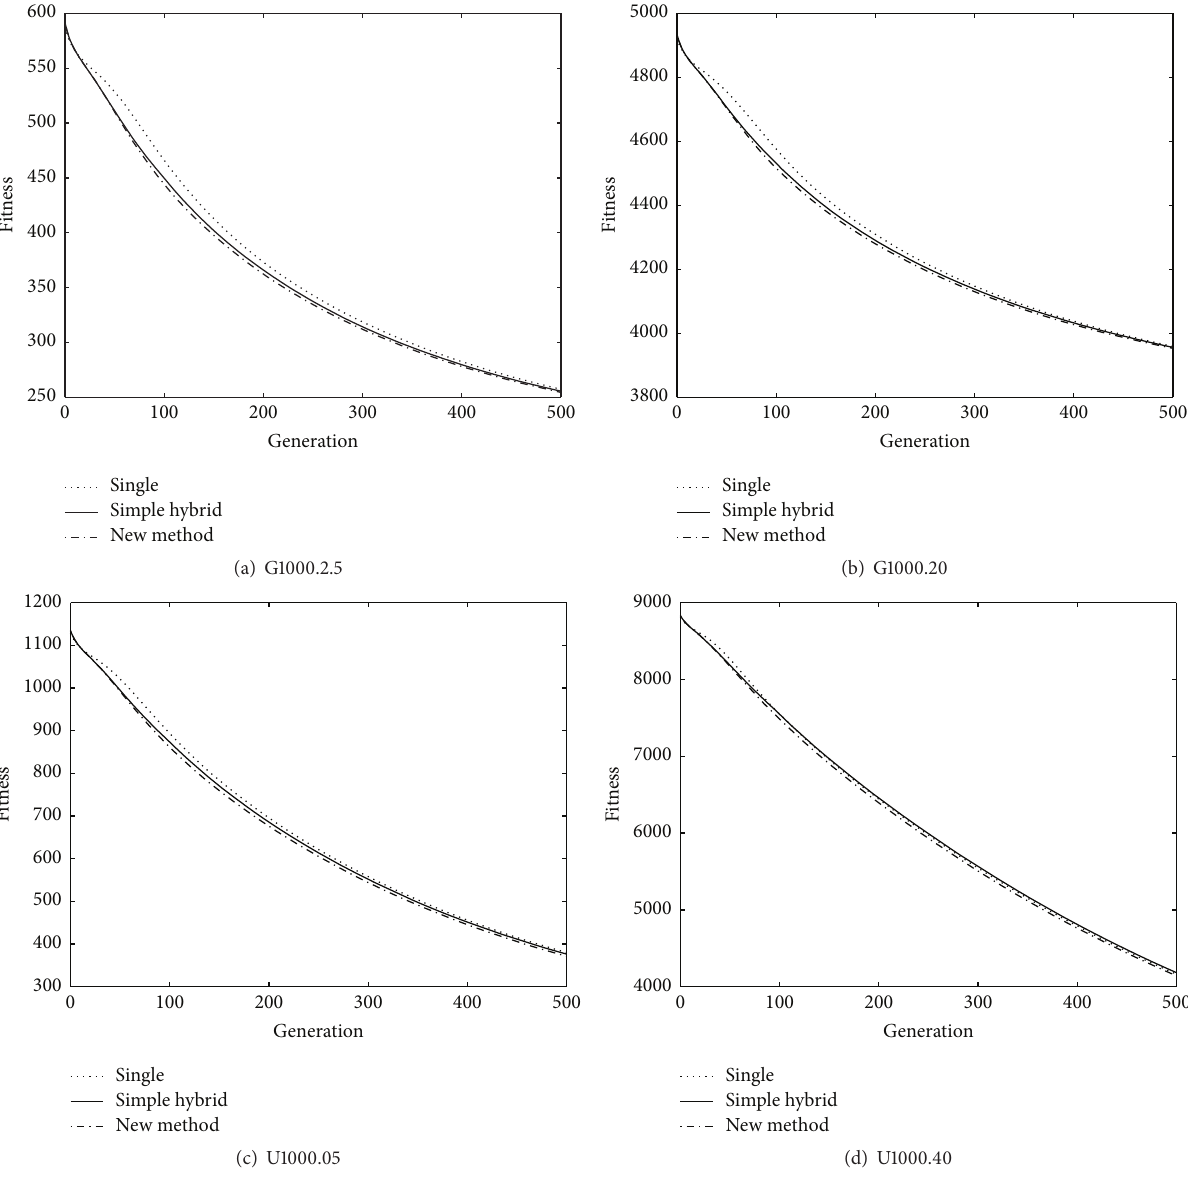
Figure 5: Fitness of mating schemes in graph bisection (the smaller, the